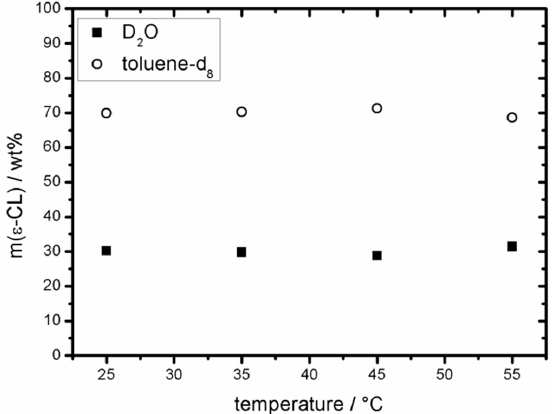
Figure 1. Distribution of ε -CL in toluene-d 8 and D 2 O measured by 1 H-NMR spectroscopy at temperatures from 25 to 55 °C.